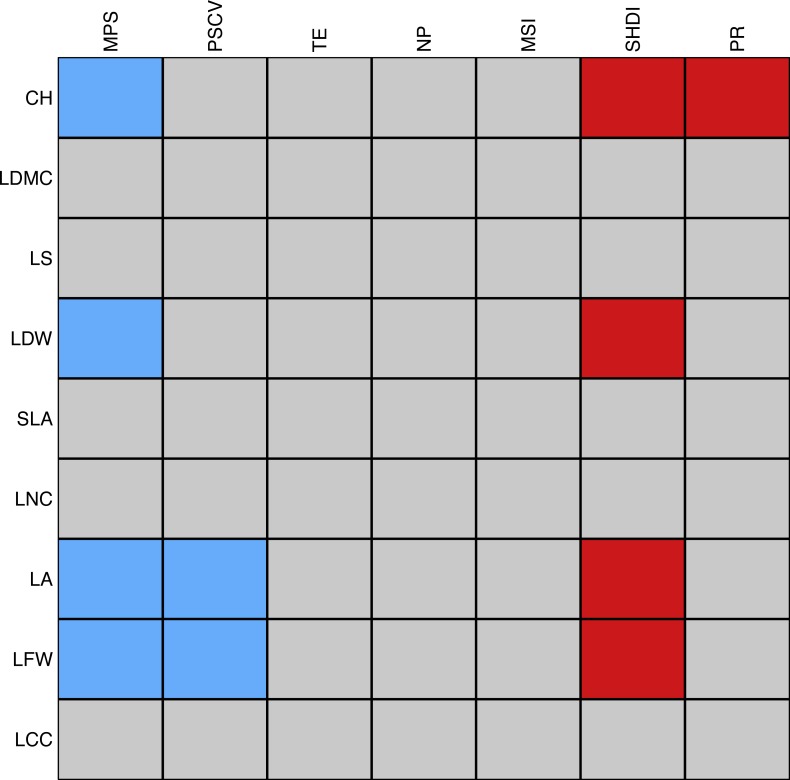
Schematic representation of the association between individual plant traits and landscape metrics.Red cells correspond to positive significant relationships while blue cells correspond to negative significant relationships. The strength of the association was measured with the D2 statistic and tested through a fourth-corner analysis (Dray et al., 2014). P-values were corrected by a sequential procedure (49,999 repetitions) which leads to significant associations if the maximum p-value was lower than \documentclass[12pt]{minimal}
\usepackage{amsmath}
\usepackage{wasysym} 
\usepackage{amsfonts} 
\usepackage{amssymb} 
\usepackage{amsbsy}
\usepackage{upgreek}
\usepackage{mathrsfs}
\setlength{\oddsidemargin}{-69pt}
\begin{document}
}{}$\alpha =\sqrt{0.05}$\end{document}α=0.05 as proposed by Dray & Legendre (2008). Abbreviations are reported in Table 1.